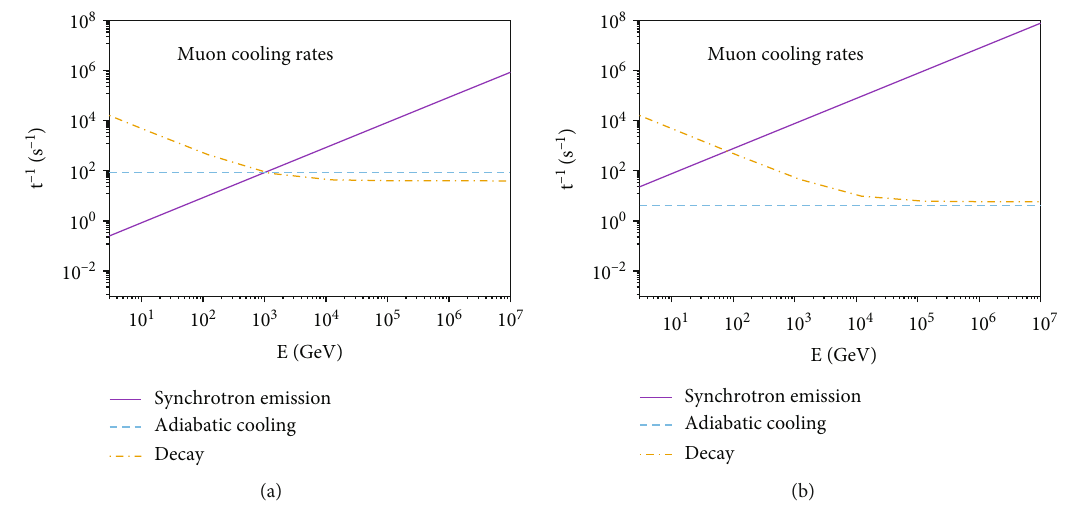
Figure 3: Cooling rates for muons in the jets of M33 X-7 (a) and SS 433 (b) at the base of the